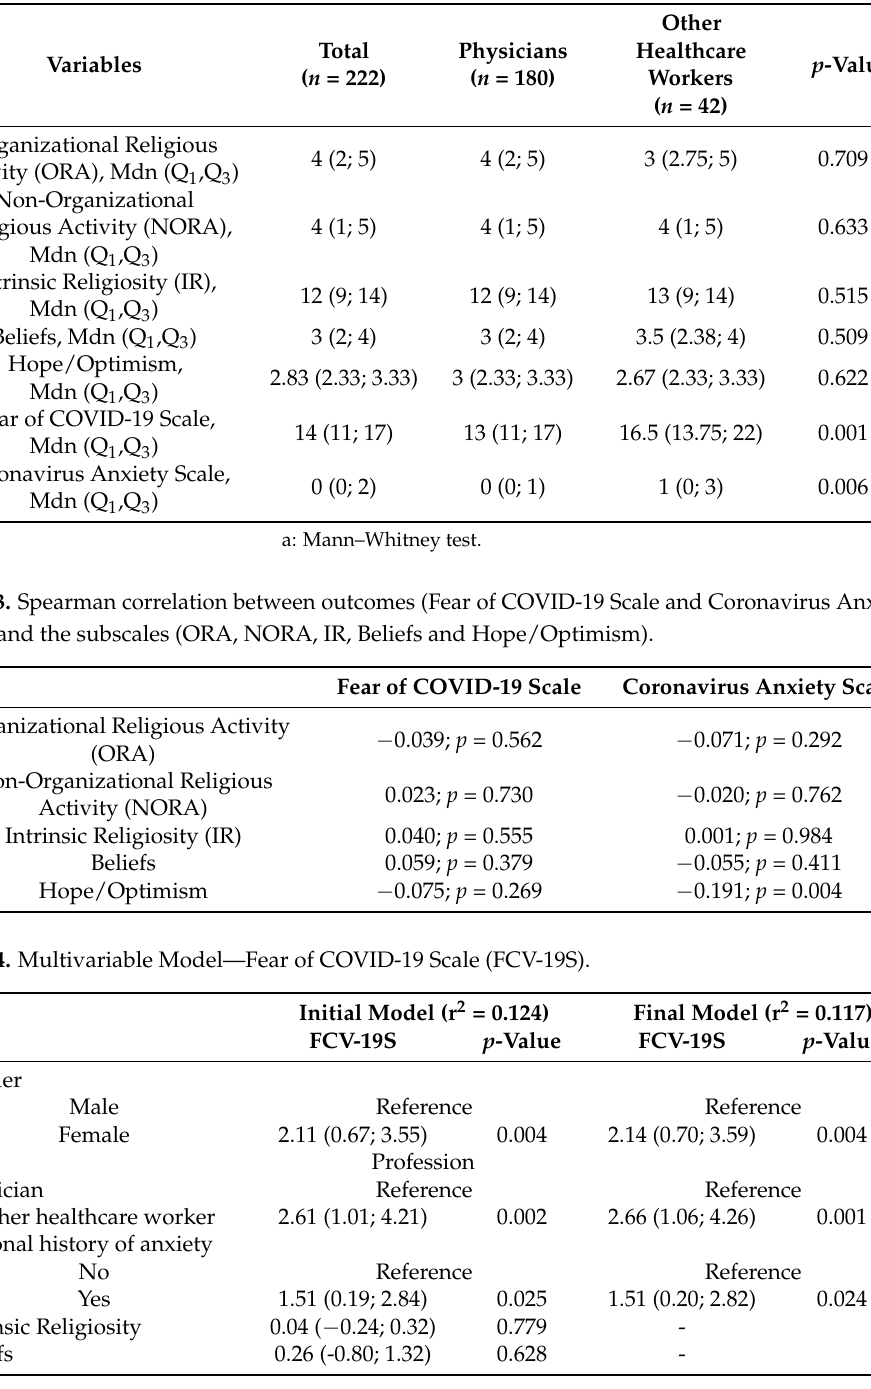
Table 2. Comparison between the 2 groups (physicians vs. other healthcare workers).